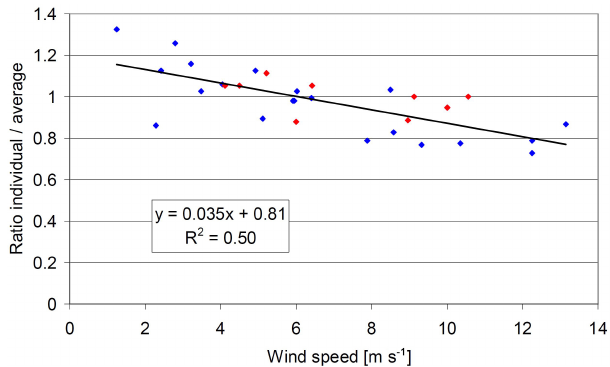
Figure 6. Dependence of the normalised partitioning ratios on wind speed (the individual ratios are divided by the seasonal average). Red points represent summer and blue points winter